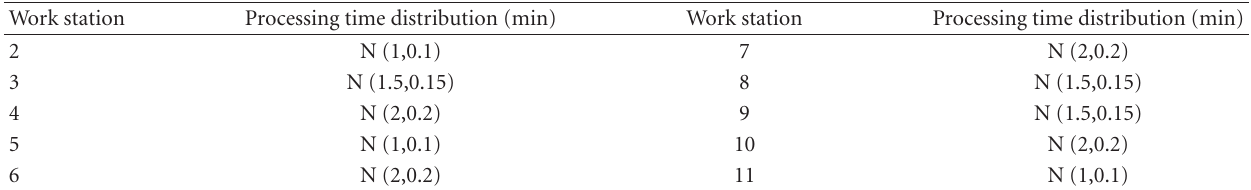
Table 4: The processing-time distribution and the production sequence of each product type.